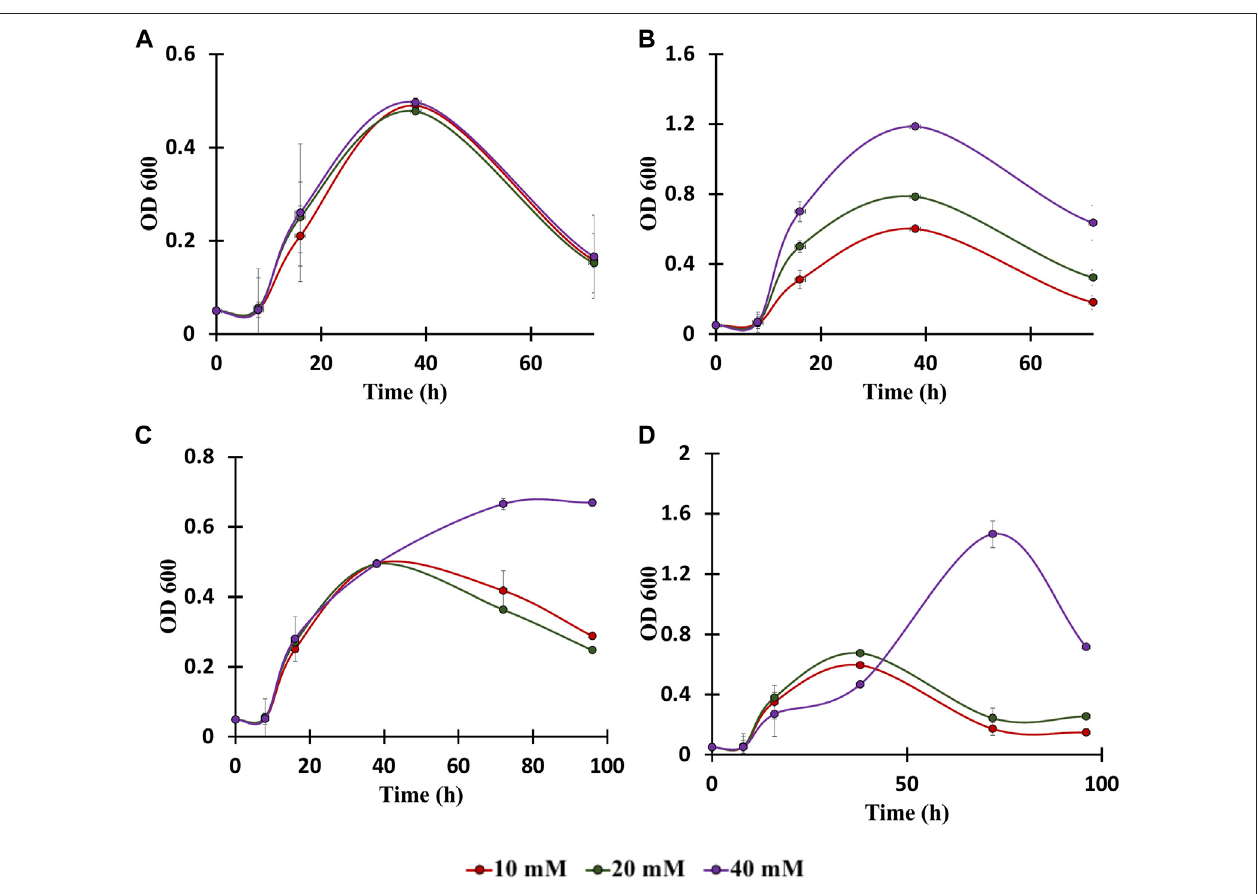
FIGURE 4 | Growth assays of C. glutamicum in: (A) vanillic acid (10, 20, 40 mM), (B) Benzoic acid (10, 20, 40 mM), (C) Cinnamic acid (10, 20, 40 mM), and (D) p- coumaric acid (10, 20, 40 mM). The experiments were performed in biological triplicates. Data represents mean ± SD, n = 3.